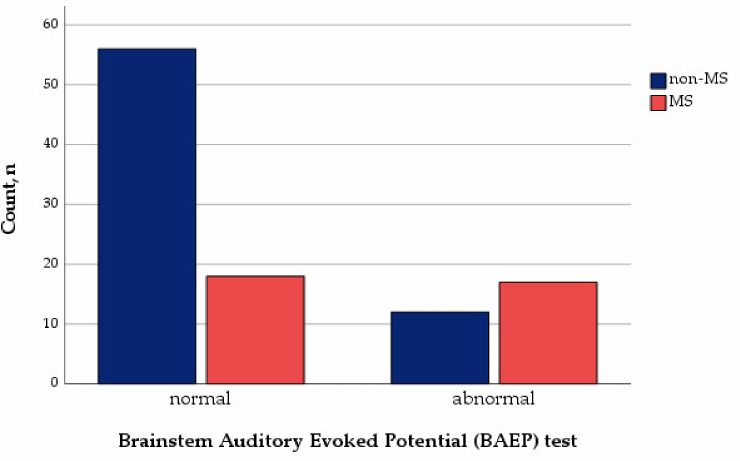
Figure 2. Brainstem Auditory Evoked Potential (BAEP) test and development of